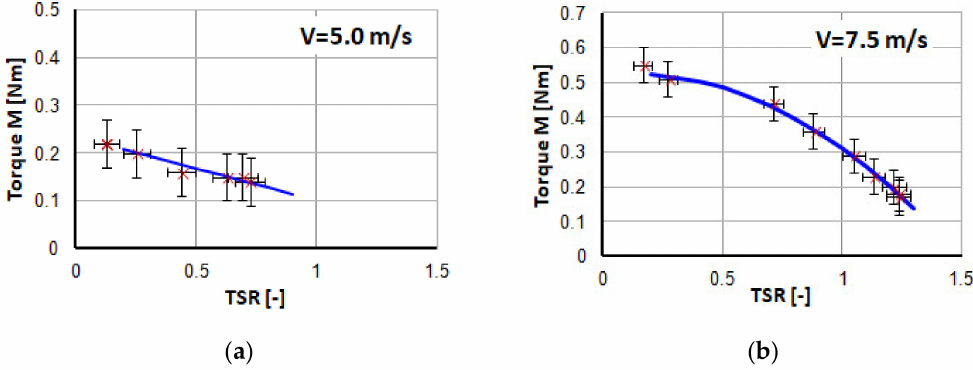
Figure 9. Torque characteristics for single-segment rotor; ( a ) velocity V = 5.0 m/s; ( b ) velocity V = 7.5 m/s. The measurement points are marked by marker ‘x’. The error bars are